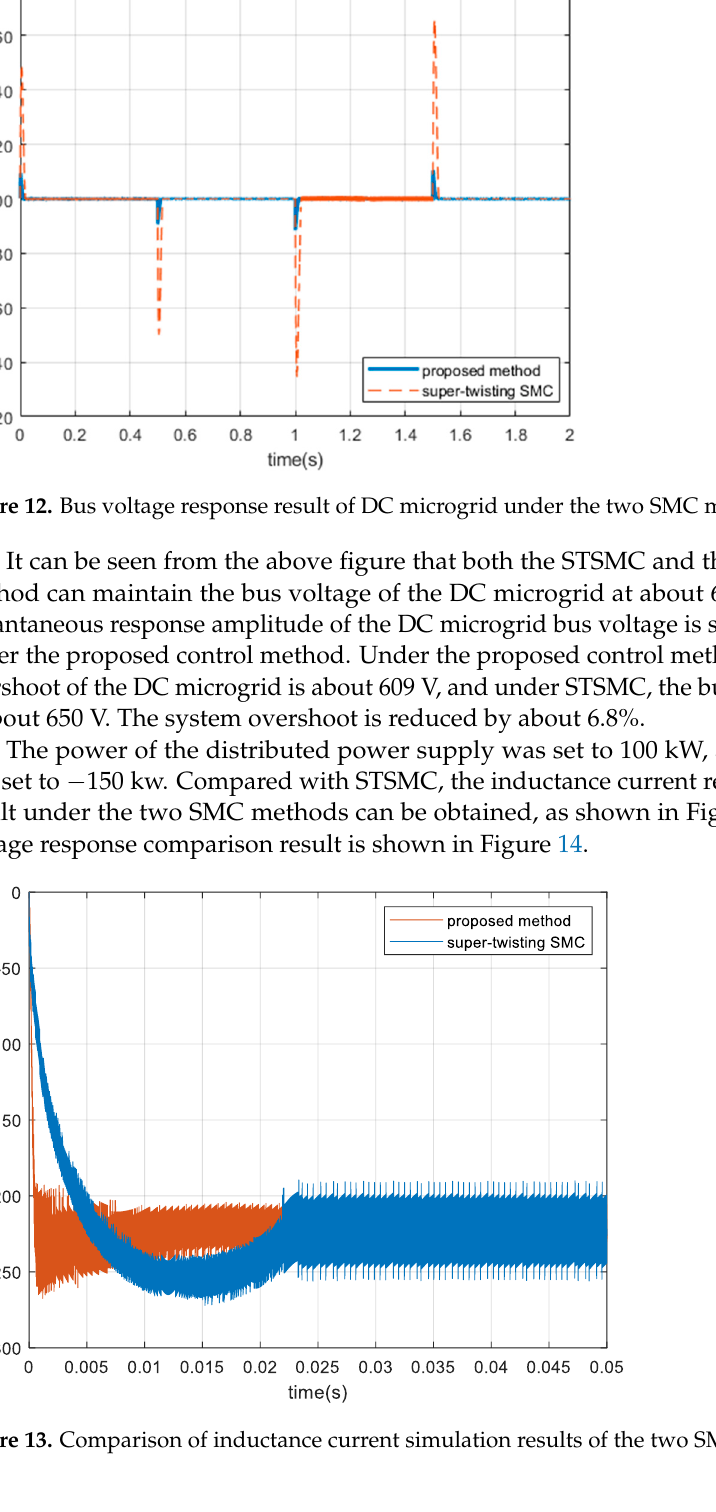
Figure 14. Comparison of bus voltage simulation results of the two SMC methods. Under STSMC, the inductance current needs to be stabilized after 22 ms, and the bus voltage needs to be stabilized after 21 ms. However, under the proposed control method, the inductance current only needs to be stabilized after 7 ms, and the bus voltage only needs to be stabilized after 13 ms. The instantaneous fluctuation range of the inductance current and the bus voltage under the proposed control method is obviously smaller than that of STSMC. Therefore, compared with STSMC, the proposed control method has a smaller instantaneous fluctuation of the inductance current and bus voltage, a faster re- sponse speed, and better robustness. In addition, the dynamic performances of the proposed control method, PI control, linear SMC, TSMC, and STSMC are compared in Figure 15, where the power changes every 0.5 s, the distributed power is set to [100, 150] kW, and the load power is set to [ − 50,